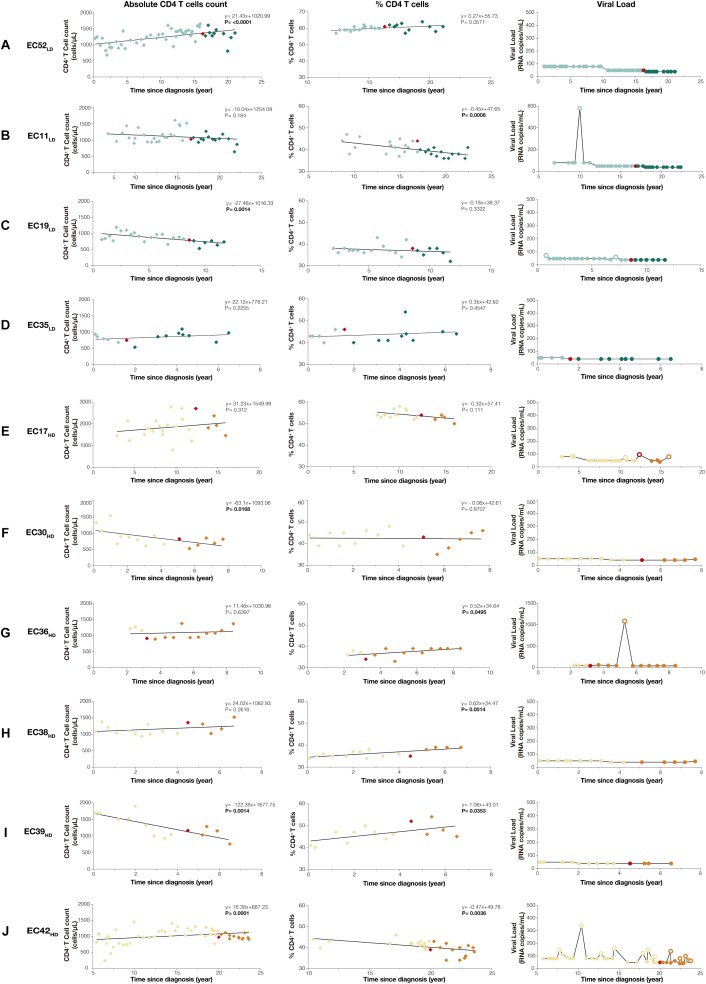
Temporal dynamics of CD4+ T cell counts and plasma viremia in ECLD
(A–D) and ECHD
(E–J) subgroups. Absolute CD4+ T cells counts (cells/μL), percentages of CD4+ T cell (%CD4) and plasma RNA viral load measurements (copies/mL) since HIV diagnosis are shown on the left, middle and right columns, respectively. The slope of CD4+ T cells and %CD4 overtime, calculated by linear regression analysis fitted by generalized least squares and with an autocorrelation structure of first order in respect to the time after HIV diagnosis, are shown with their respective P-values in the upper right corner of each graph. The red symbols (diamonds or circles) indicate the time point selected for analysis of env proviral diversity, while light and dark colored symbols indicate pre- and post-period of env proviral diversity determination, respectively. RNA viral load measurements below and above the detection limit were represented by fill and empty circles, respectively. ECLD and ECHD subjects were represented by green and orange symbols, respectively.